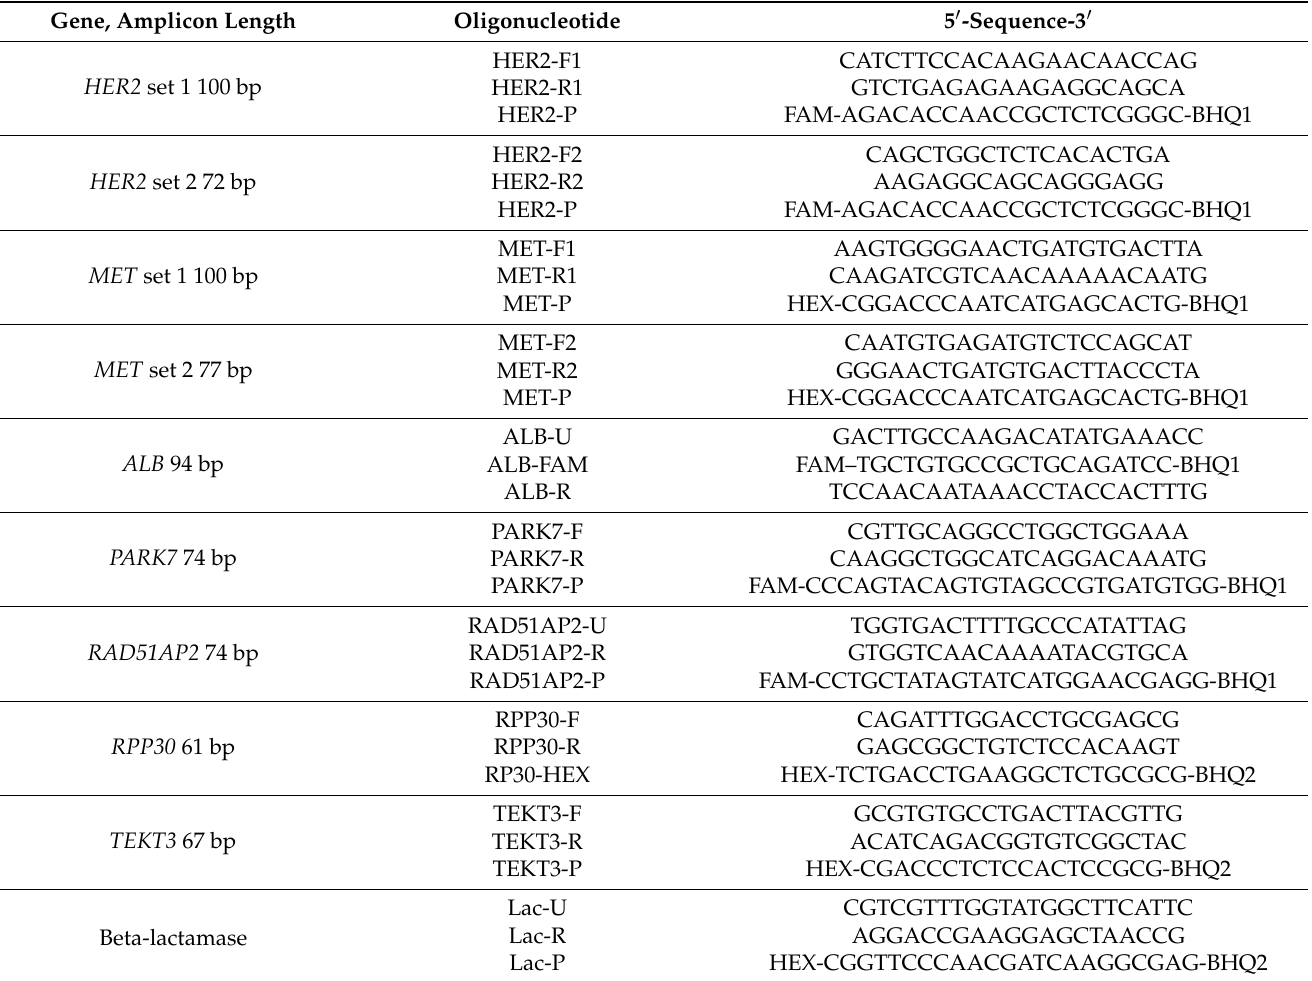
Table 1. Sequences of primers and